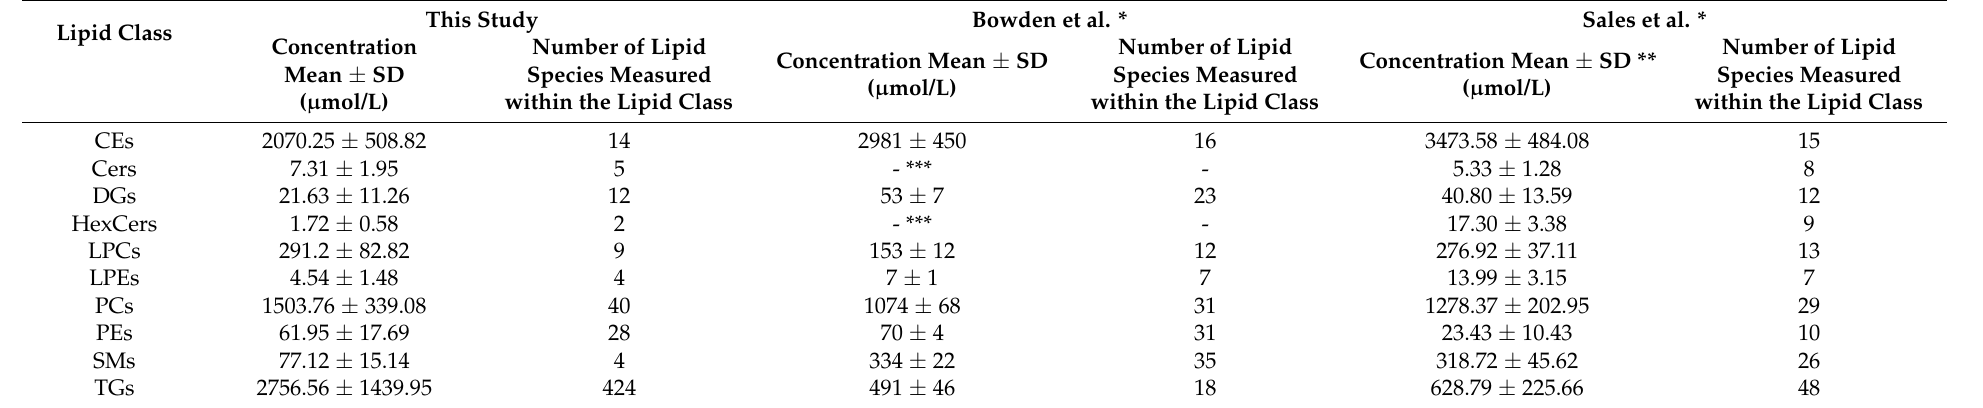
Table 6. Comparison of the concentrations of lipid classes determined by Bowden et al., Sales et al., and in this